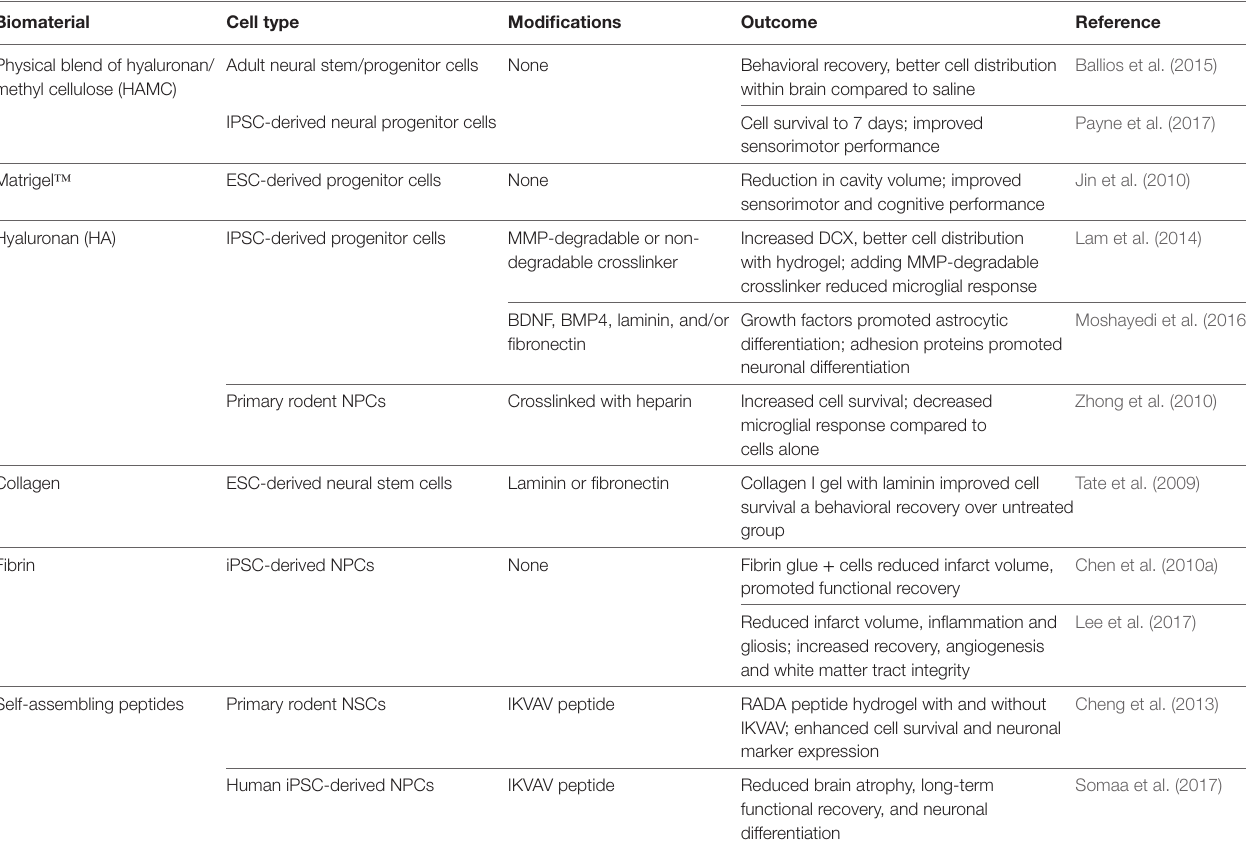
TABLe 2 | Naturally-derived biomaterials for cell delivery to the brain.